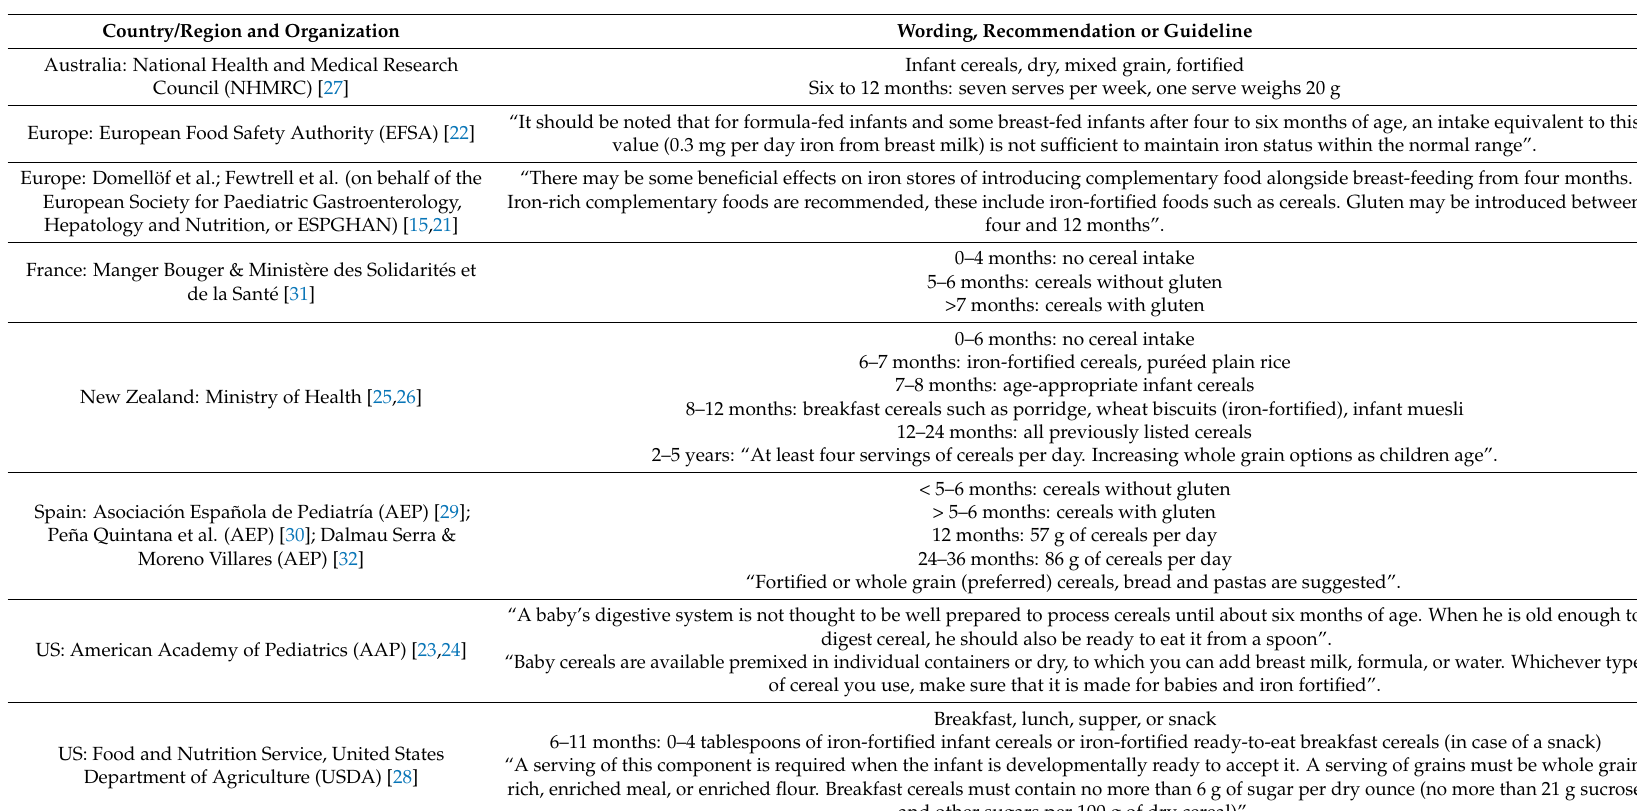
Table 1. Examples of cereal recommendations for infants and young